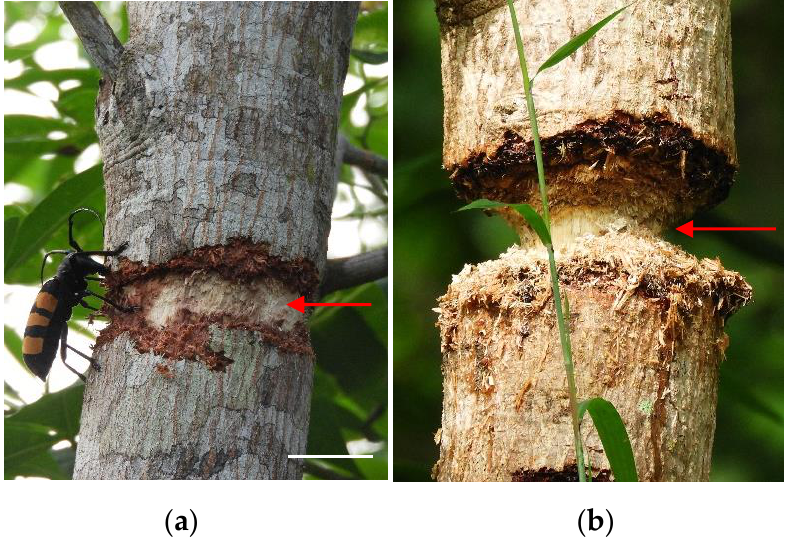
Figure 2. Levels of attack on branches used to estimate D. trifasciata damage intensity; ( a ) type 1 girdled branch: type 1 attacks were made up of girdled branches and/or stems where only the bark had been attacked, scale bar 3.6 cm; ( b ) type 2 deep girdling or cut branch: type 2 attacks included cut branches and/or stems whose attack had reached the sapwood, scale bar 2.83 cm. Red arrows indicate attacked area.